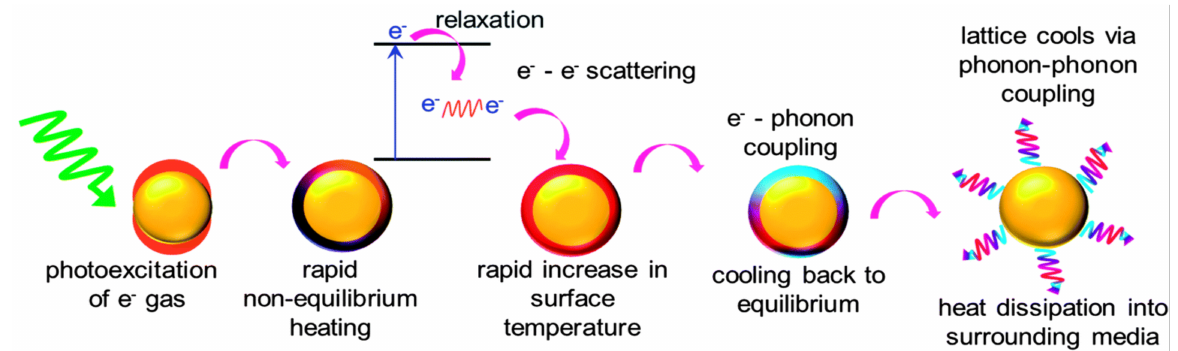
Figure 4. Description of photothermal light to heat conversion by plasmonic nanostructures [55]. Reprinted with permission from Ref. [55], Copyright 2014, The Royal Society of